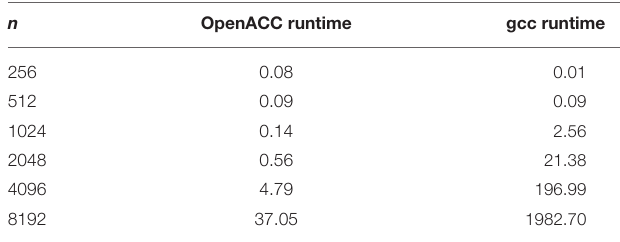
FIGURE 8 | Influence of problem size on the runtime of the serial version (gcc) compared to the OpenACC version. TABLE 3 | Runtimes of matrix multiplication with different problem